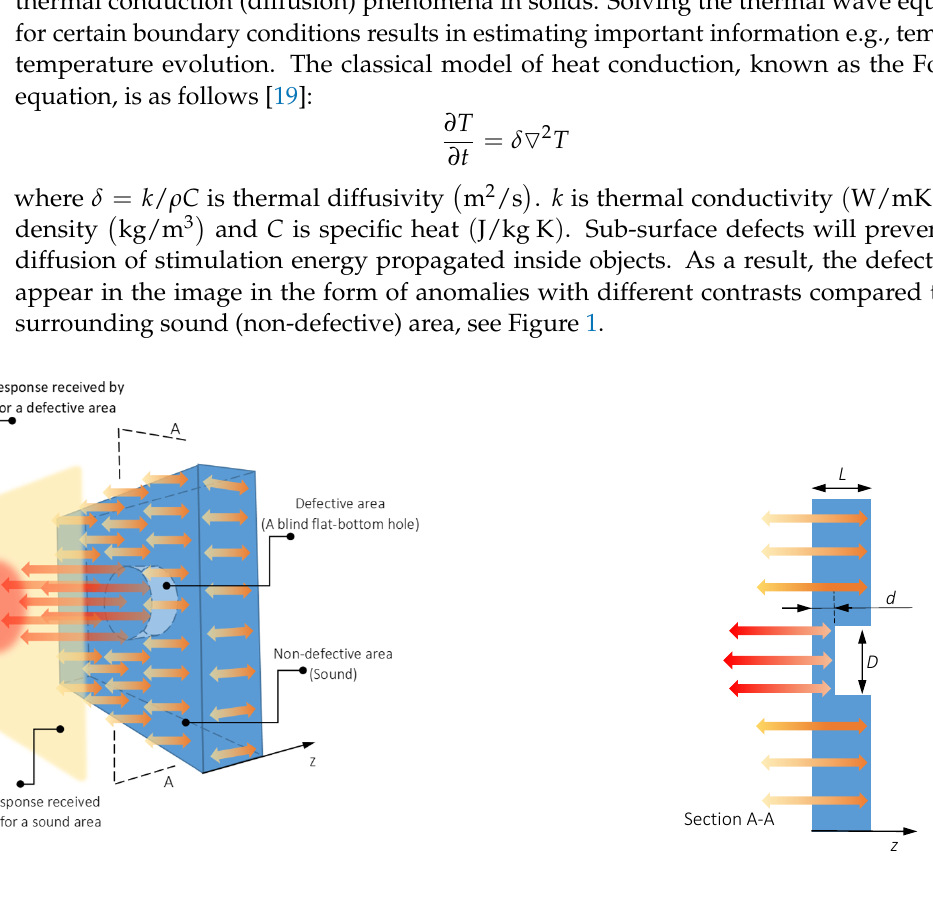
Figure 1. Schematic of thermal diffusion and response through a defective solid [1] Reproduced with permission from Infrared Physics & Technology, Elsevier, 2019. Licence number 5106340697590.